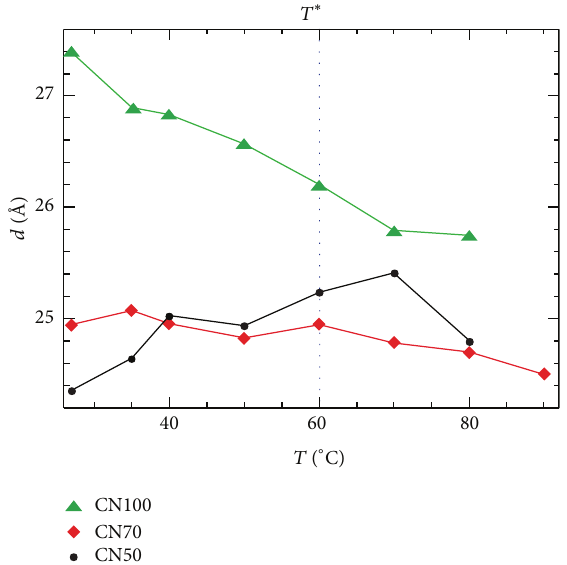
Figure 2: Layer spacing, 𝑑 ( ˚A ) versus temperature, 𝑇 ( ∘ C), for smectic clusters in ∙ CN50, X CN70, and 󳵳 CN100. The data points are connected by lines.